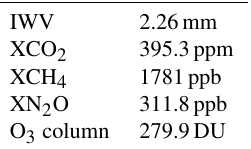
Table A2. Mean atmospheric state of the closure data set: trace gas column amounts. The data set was selected from Zugspitze solar FTIR spectra measured from December 2013 to February 2014 and contains 52 spectra. Spectra selection criteria are listed in Sect.